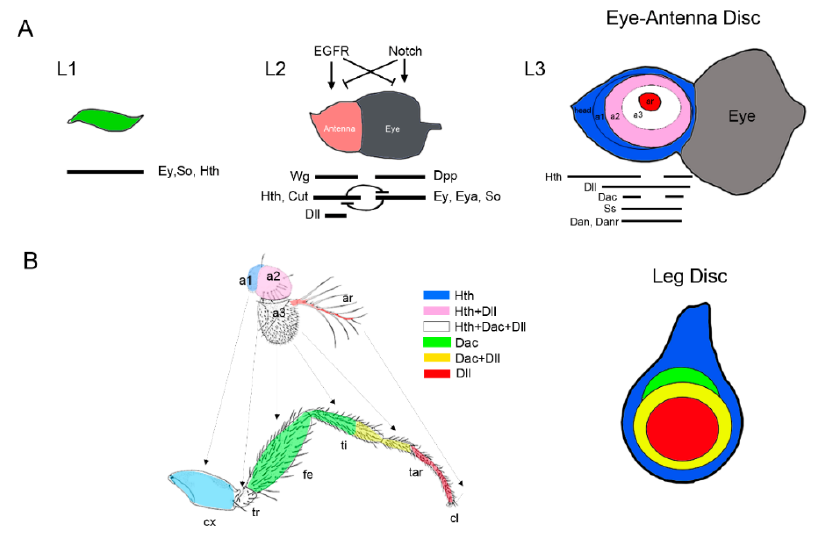
Figure 4. Specification and patterning of the Drosophila antenna. ( A ) Model of progressive specification of the eye and antenna territories and P-D subdivision of the antenna disc. Schematic representation of three representative stages of EAD development is shown. In each disc the expression and interactions of genes and signaling pathways required for eye and antenna field specification are schematized. ( B ) The antenna and leg appendages are homologous structures. Arrows indicate the correspondence between the antenna and leg domains (Postlethwait and Schneiderman, 1971). The expression of the P-D genes Dll , dac , and hth and their overlapping domains are represented by a color code. Compare the relative expression of Dll , dac , and hth in the antenna and the leg imaginal discs. Note that hth and Dll coexpress in a large domain in the antenna while in the leg these genes are expressed in almost exclusive domains.